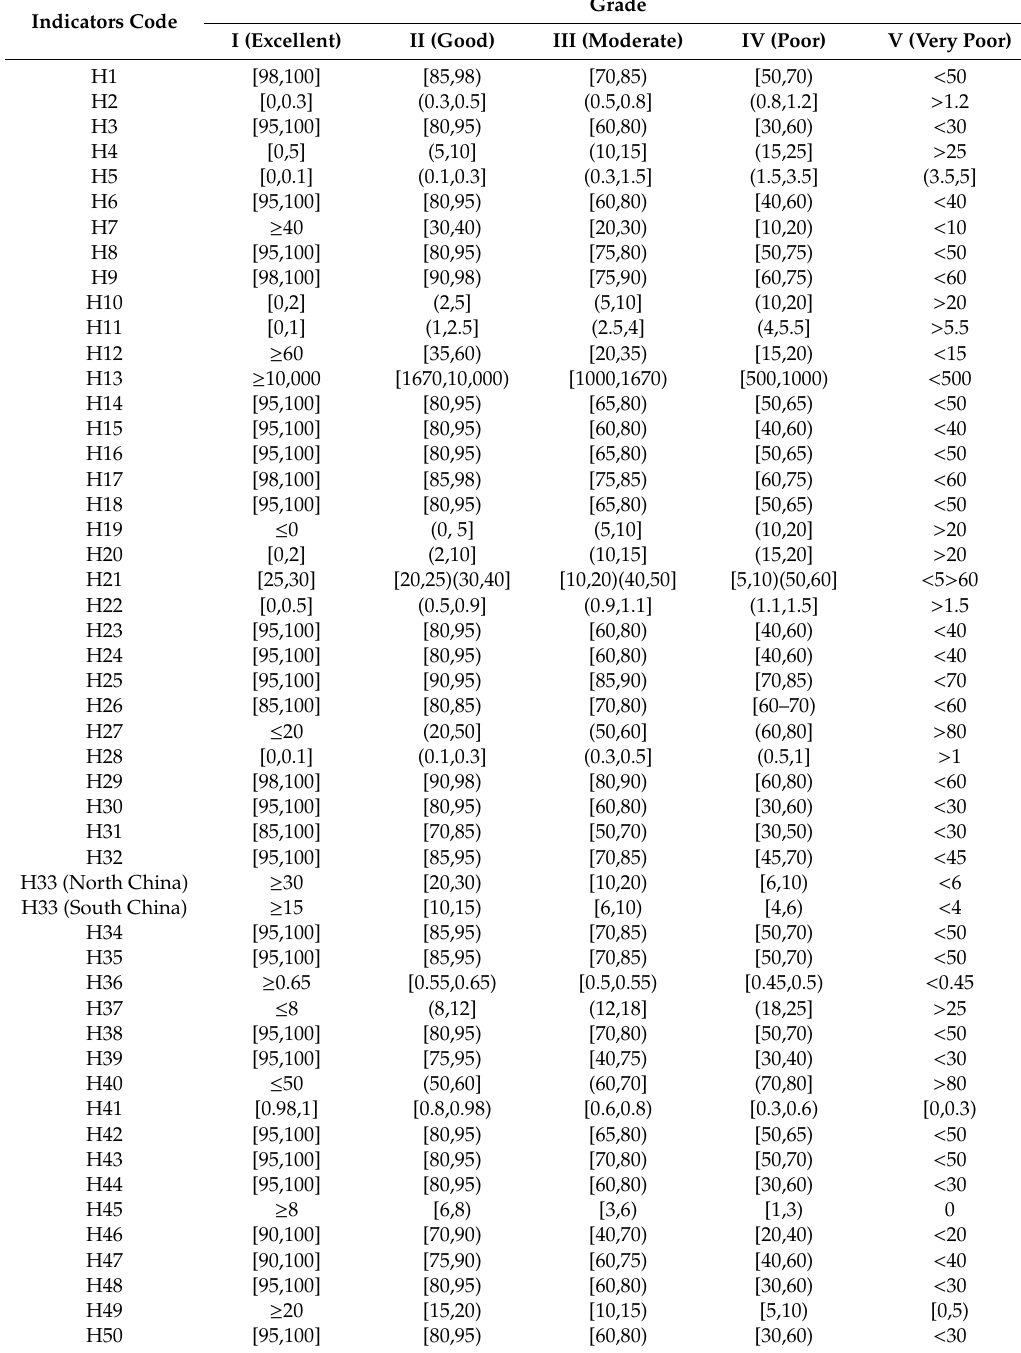
Table 2. Evaluation standards of the Happy River Index (HRI) Evaluation